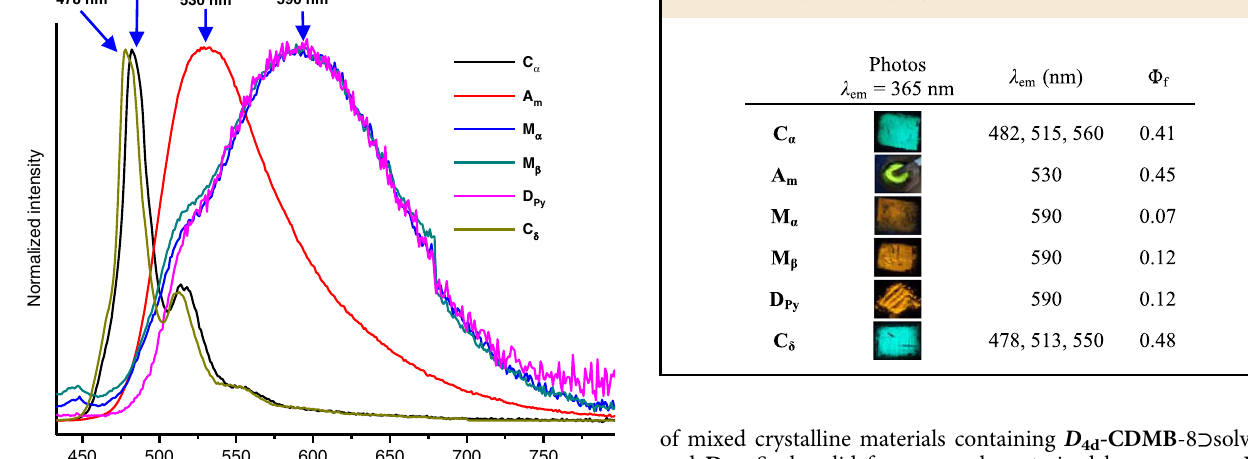
Table 1 Photophysical properties of various solid